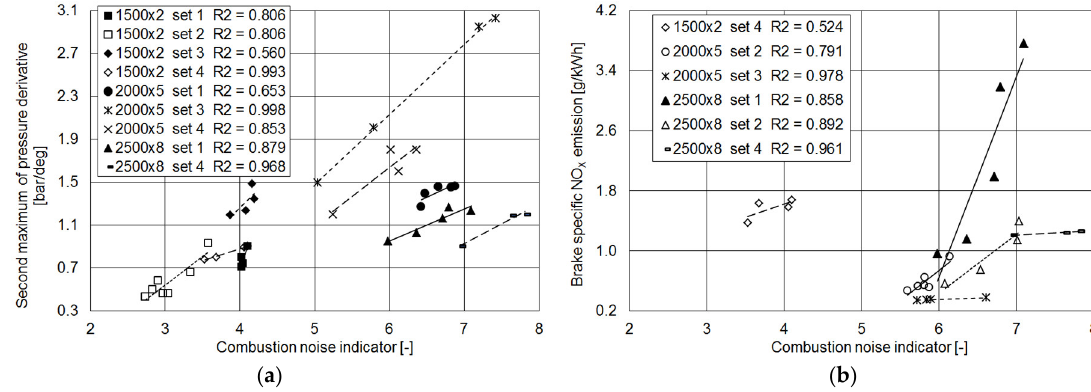
Figure 11. Relationship between I n and (dp/dθ) MAX 2 ( a ), bSNO X ( b ) in different test sets.